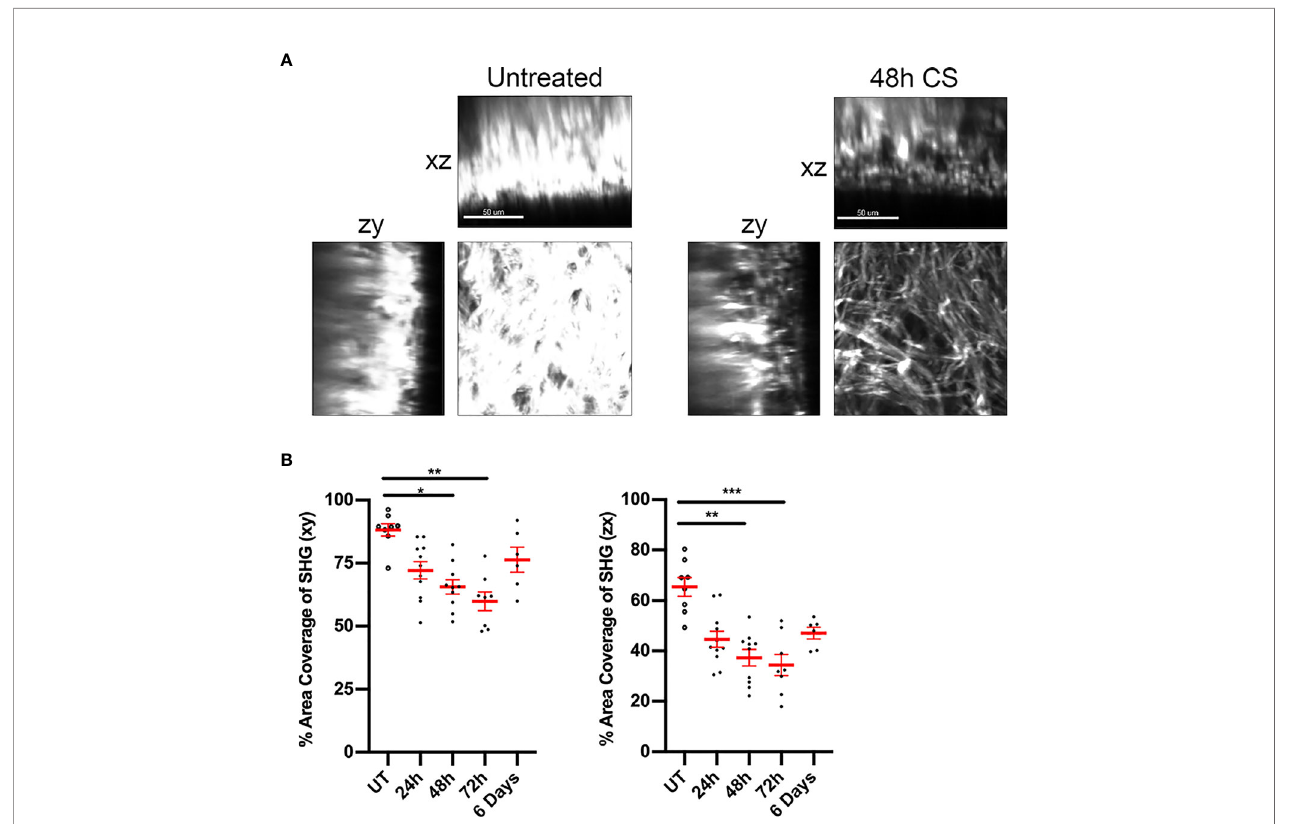
FIGURE 2 | CS alters ECM fi bre distribution in fl ank skin. The effect of CS-induced in fl ammation on the distribution of dermal collagen fi bres was assessed via SHG in MP-IVM experiments. (A) Example images of collagen fi bre distribution in untreated skin and at 48 h post CS induction. Images represent single planes from 3D volumes in either the planar (xy), zx or zy planes. Scale bar - 50 µm. (B) Percentage of area fi lled by SHG signal in or the xy or zx cross sections, taken 60 µm below the skin surface. Data are shown for individual mice and as mean ± SEM from 3-7 mice per group. Data were analysed using Kruskal-Wallis test with Dunn ’ s multiple comparison. * p < 0.05, ** p < 0.01, *** p < 0.001 for comparisons